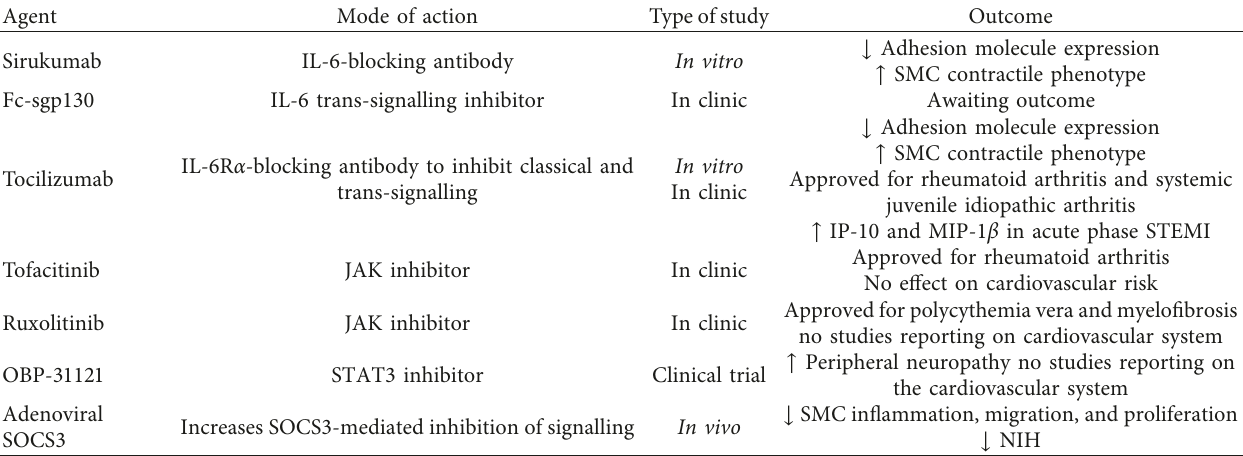
Table 1: Selected IL-6–JAK/STAT–SOCS3 modulators and their impact on cardiovascular